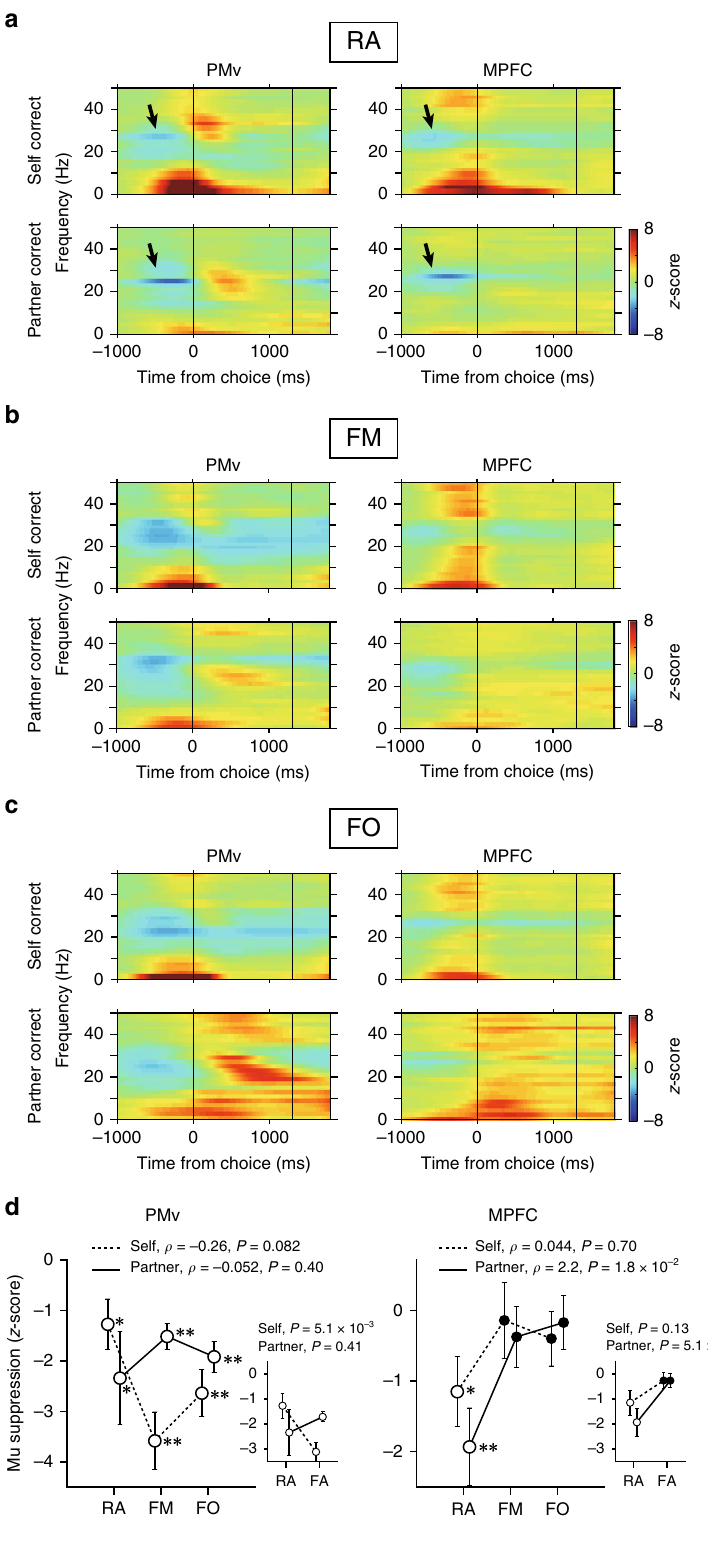
The coherence power in the delta band was not signi fi cantly associated with the partner ’ s biological nature ( ρ = − 6.5 × 10 − 3 , P = 0.38 for self-correct, ρ = 0.086, P = 0.49 for partner-correct; Spearman correlation test; Supplementary Fig. 10) or was not signi fi cantly different between the RA and FA conditions (self-